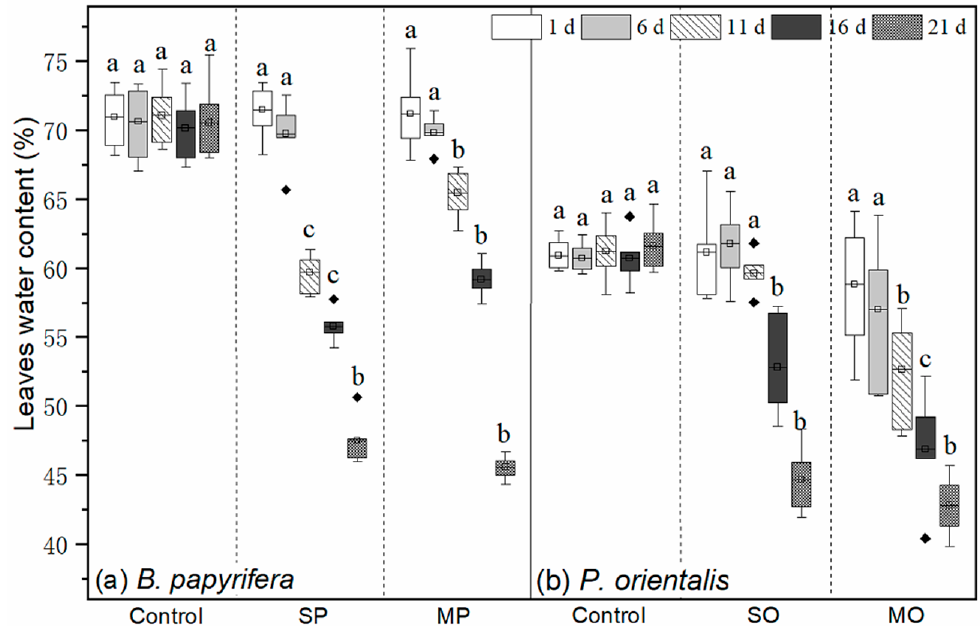
Figure 3. Leaf water contents in B. papyrifera and P. orientalis . Letters denote significant differences among different planting and treatment modes ( p < 0.05). SP— B. papyrifera under solo planting, MP— B. papyrifera under mixed planting, SO— P. orientalis under mixed planting, MO— P. orientalis under mixed planting.